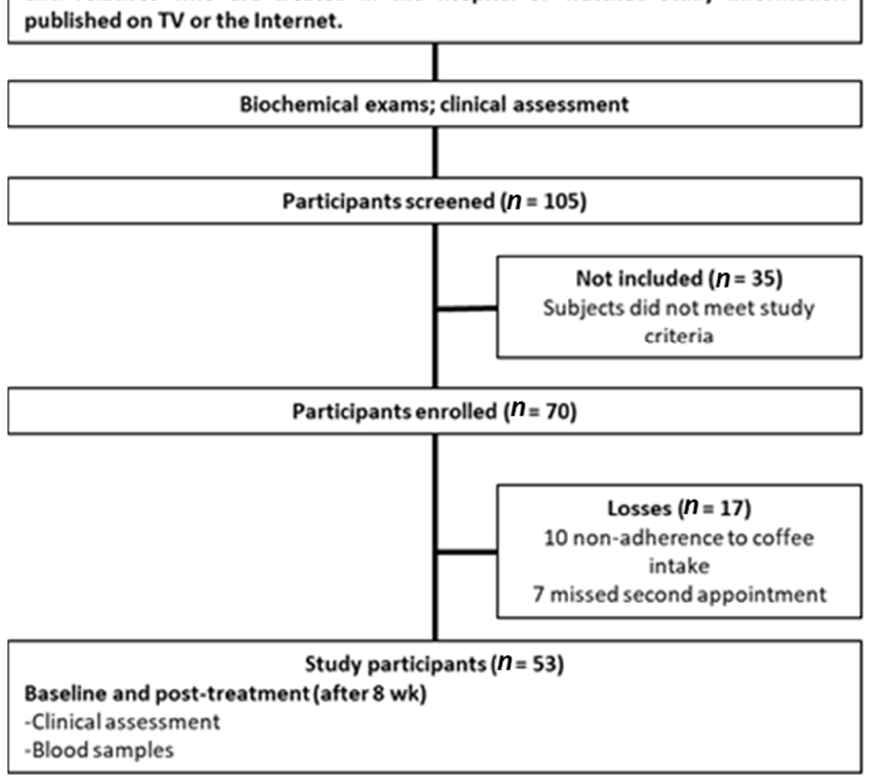
Figure 1. Flow diagram of participant progress through the study.